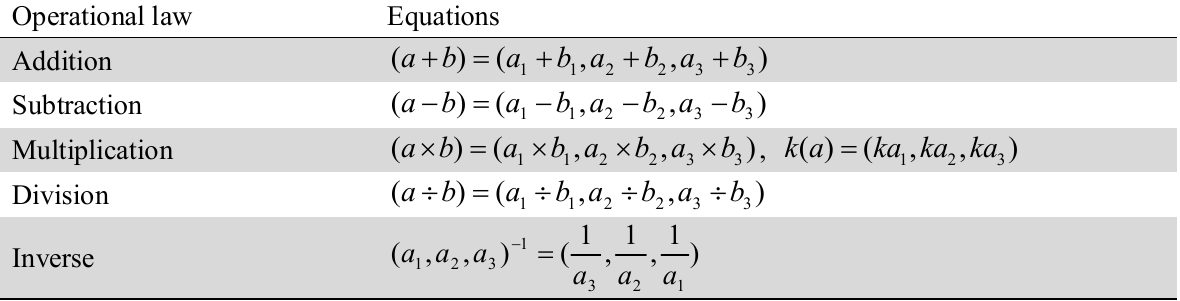
Basic equations of the two triangular fuzzy numbers (Zimmermann, 1992) Operational law